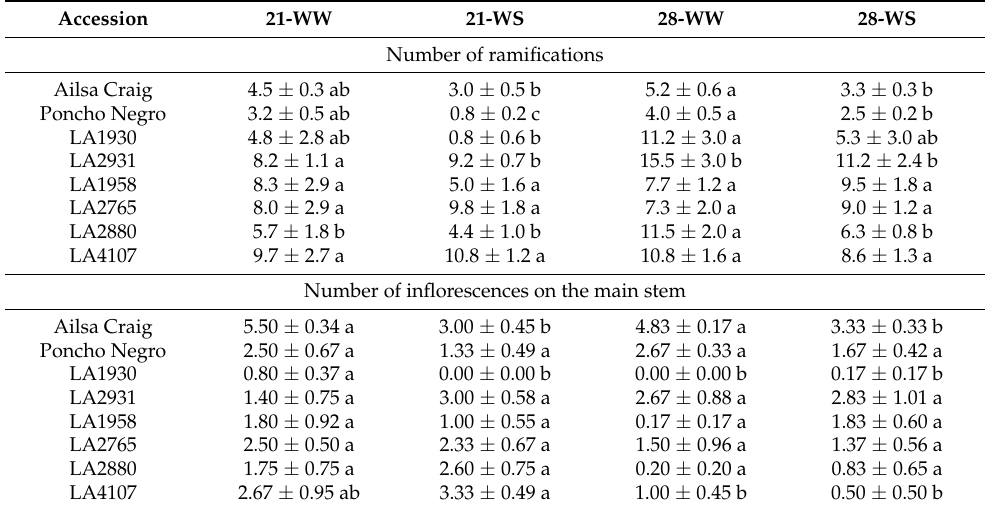
Table 1. Effect of temperature and water stress on the number of ramifications and inflorescences of S. lycopersicum cultivars and S. chilense populations. For a given accession, treatments followed by different letters are significantly different at p < 0.05. Data ± SE.